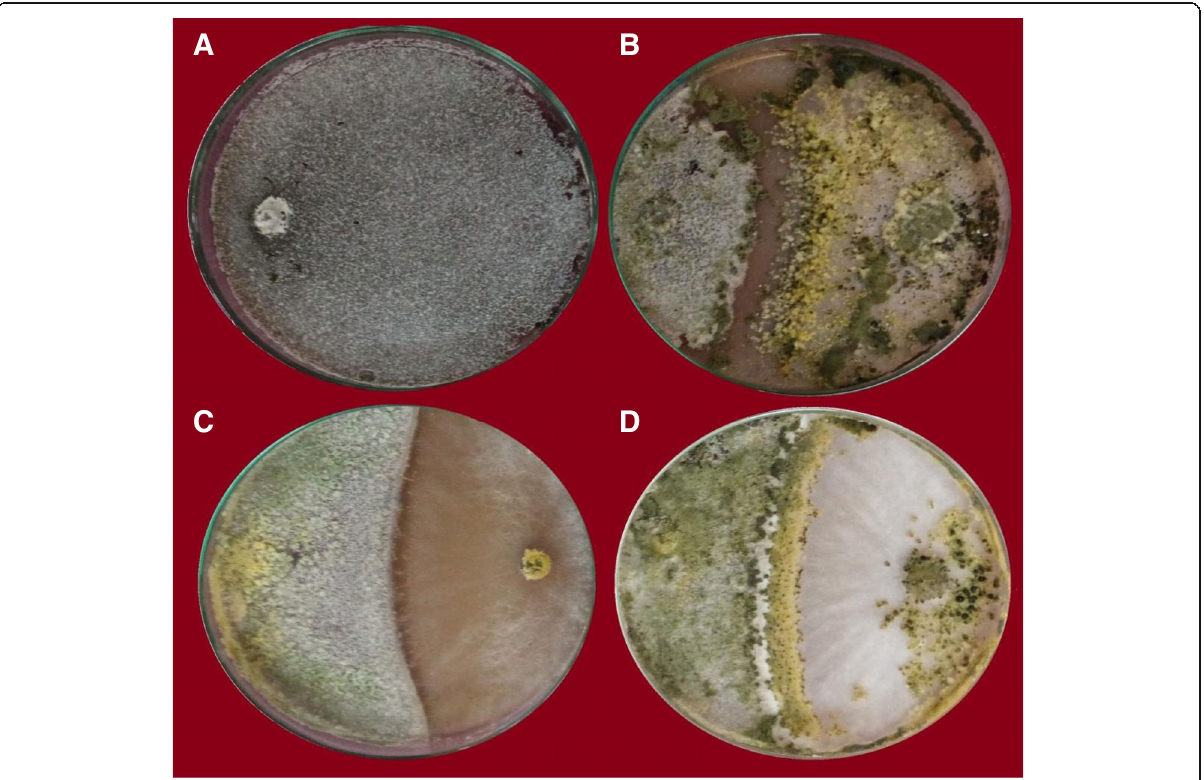
Fig. 1 Antagonistic effect of Trichoderma species on Stromatinia cepivora growth. a Stromatinia cepivora alone (control), b Stromatinia cepivora in the presence of T . harzianum , c S . cepivora in the presence of T . koningii , and d S . cepivora in the presence of T . virens